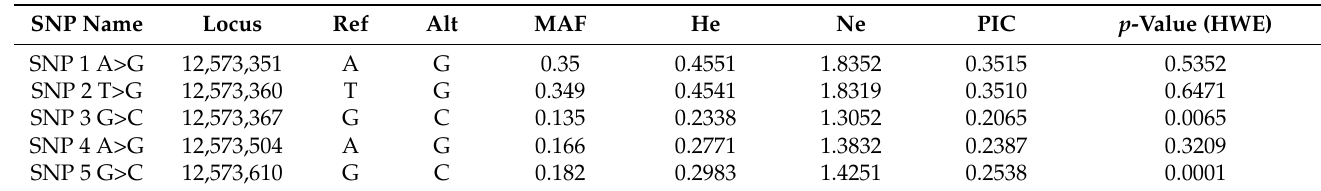
the table headings, “Ref” represents the base of the reference sequence. “Alt” represents the mutated base. “MAF” refers to the minor allele frequency. “He” refers to the degree of heterozygosity obtained theoretically. “Ne” refers to the reciprocal homozygosity in a population, which is one of the parameters used to measure a population’s genetic variation. “PIC” is one of the parameters used to measure the variation degree of a genetic marker. “ p -value (HWE)” refers to the value of the Hardy–Weinberg equilibrium calculated by the Chi-square test.